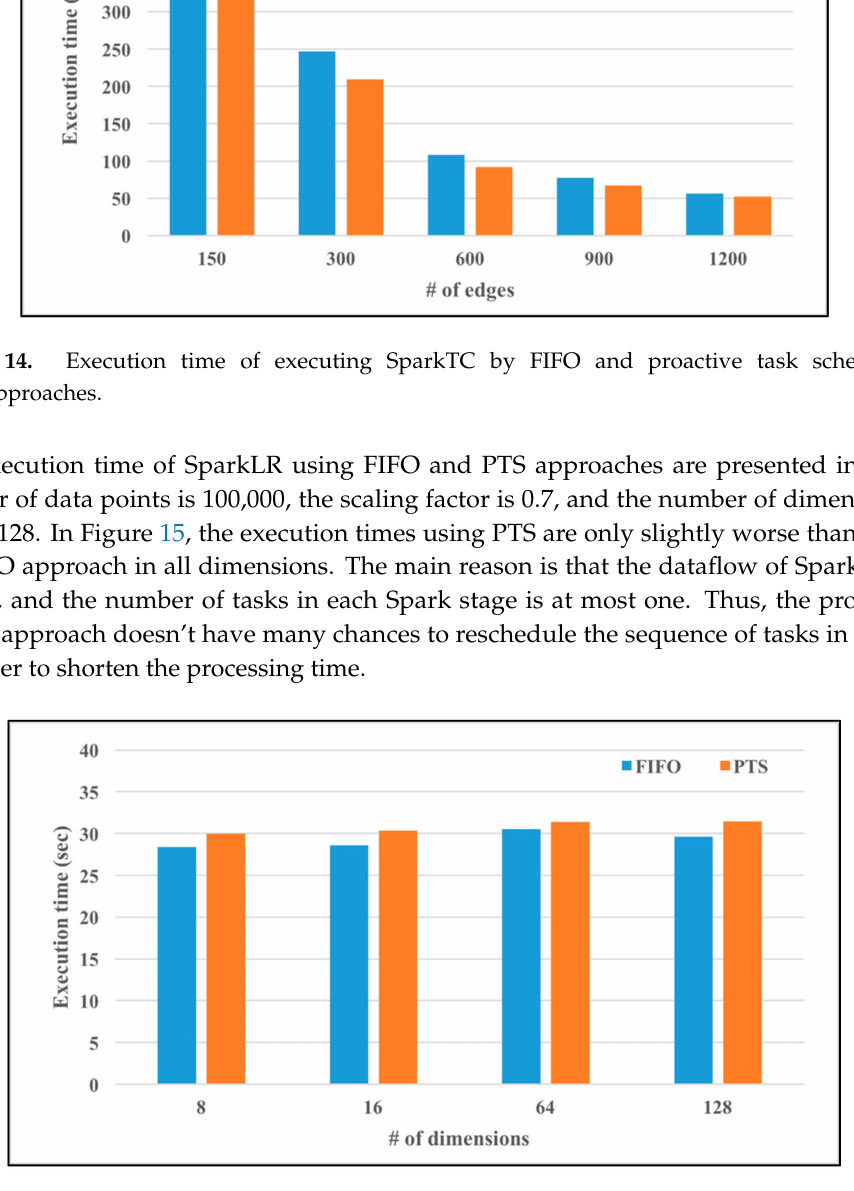
Figure 15. Execution time of executing SparkLR by FIFO and by PTS